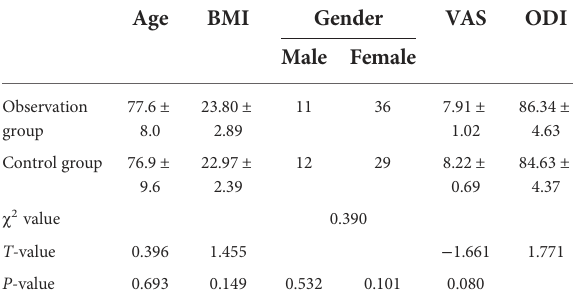
TABLE 1 General information and comparison of patients enrolled in the